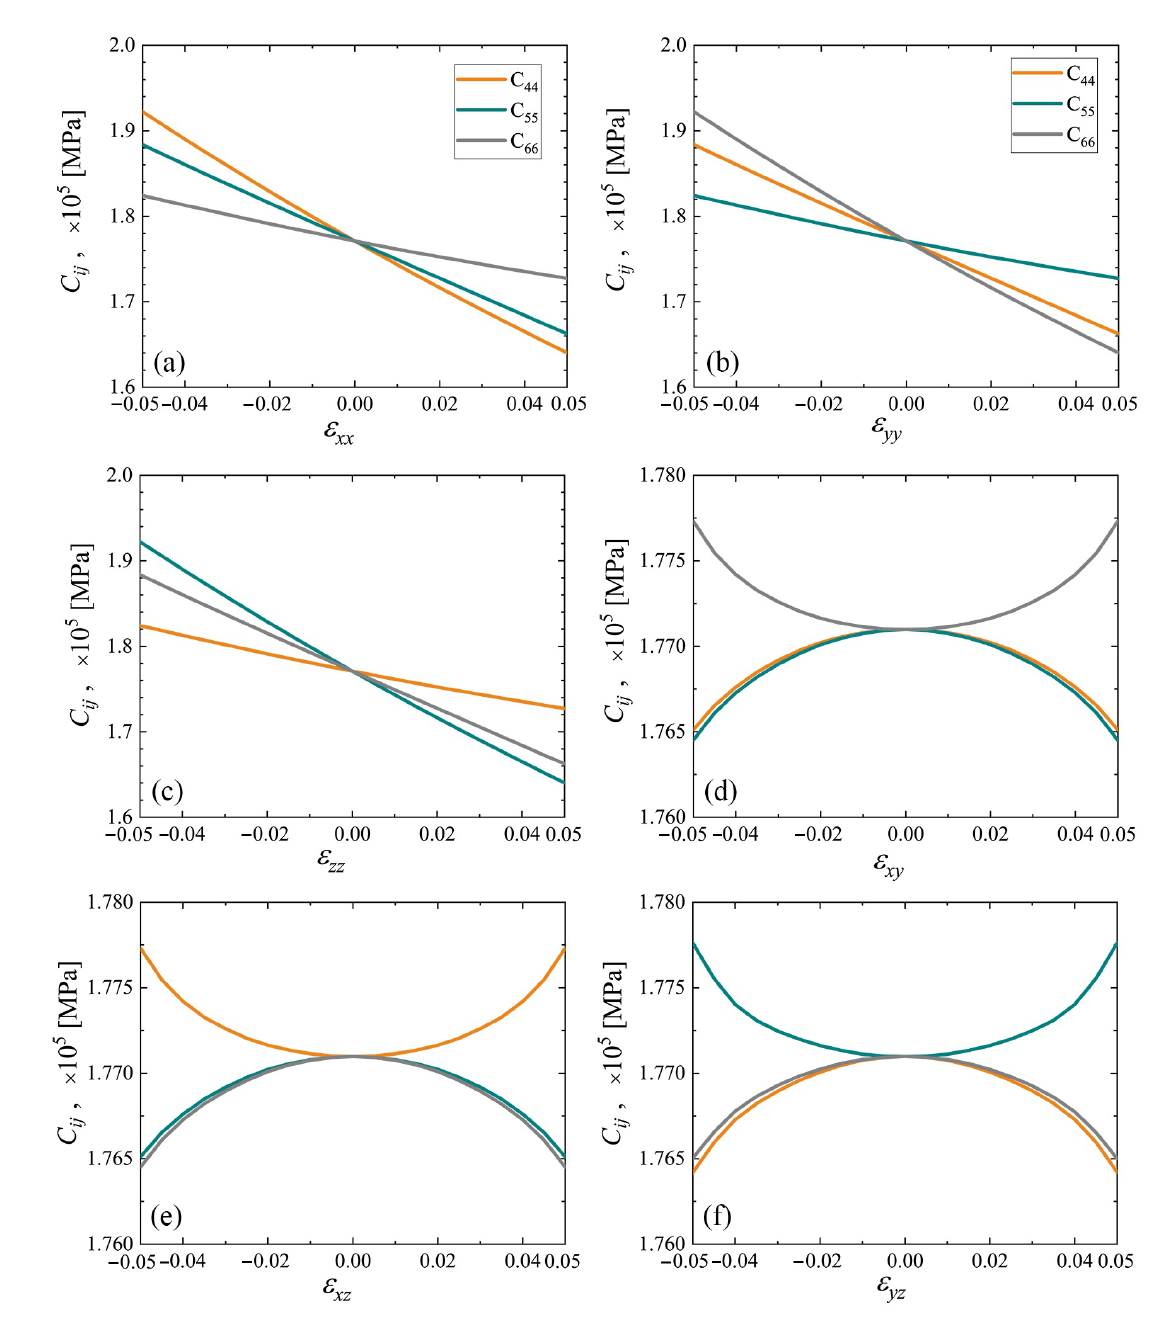
Figure 9. Elastic constants C 44 , C 55 , and C 66 as the functions of strain for cubic cubene crystal (yellow, cyan, and gray lines, respectively). Only one component of the strain tensor is varied, the rest are equal to zero. Panels ( a – f ) correspond to changing ε xx to ε yz ,